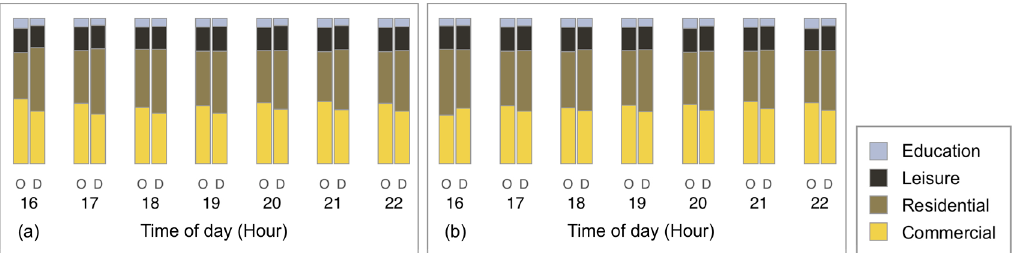
Figure 9. The proportions of origins and destinations associated with di ff erent land uses during weekdays for students on ( a ) Mondays to Thursdays, and ( b ) Fridays.